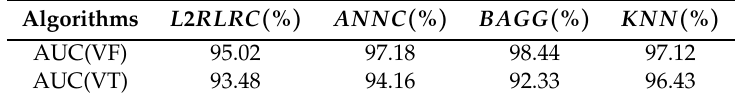
Figure 8. ROC curve for heirarchical method (HM) classification combination methods in detection of VF ( a ) and VT ( b ). Table 15. Area under the curve (AUC) values for VF and VT in L 2 RLR , ANNC , BAGG , and KNN individual algorithms.